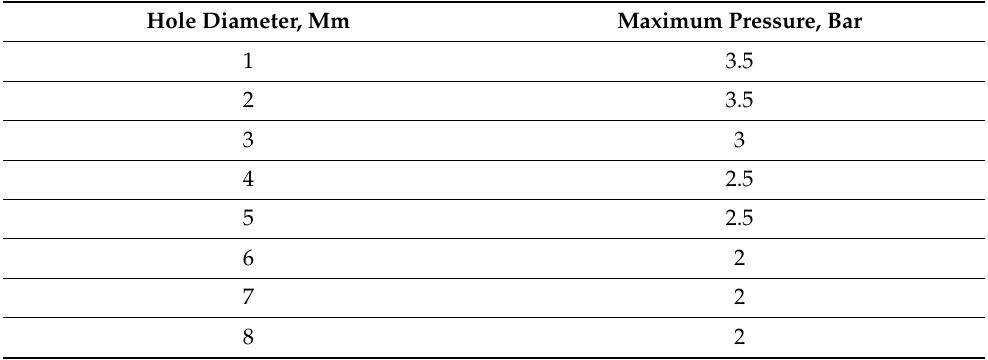
Table 2. Maximum pump discharge pressure at different bore diameters.